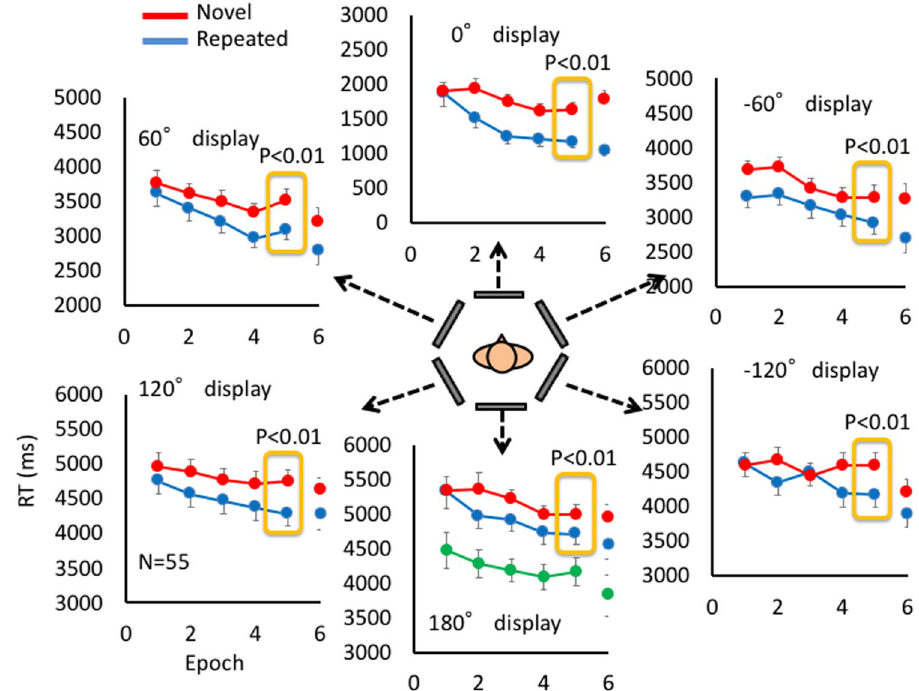
Figure 2. Reaction time to search for the target as a function of epoch (five blocks) for each display. The 0° display indicates the front display, the display in the front at the initial body location, and the other displays is labeled with the angle from the initial display with positive values in the counter-clockwise direction. The red line shows the RT of novel layouts and the blue one shows the RT of repeated layouts. The green line on 180° display shows the RT of explicit layout. The results of t-test result for the difference between repeated and novel layouts at the last epoch is shown for each display. The data points at epoch 6 (last five blocks) are the results of group A (26 observers), who completed 30